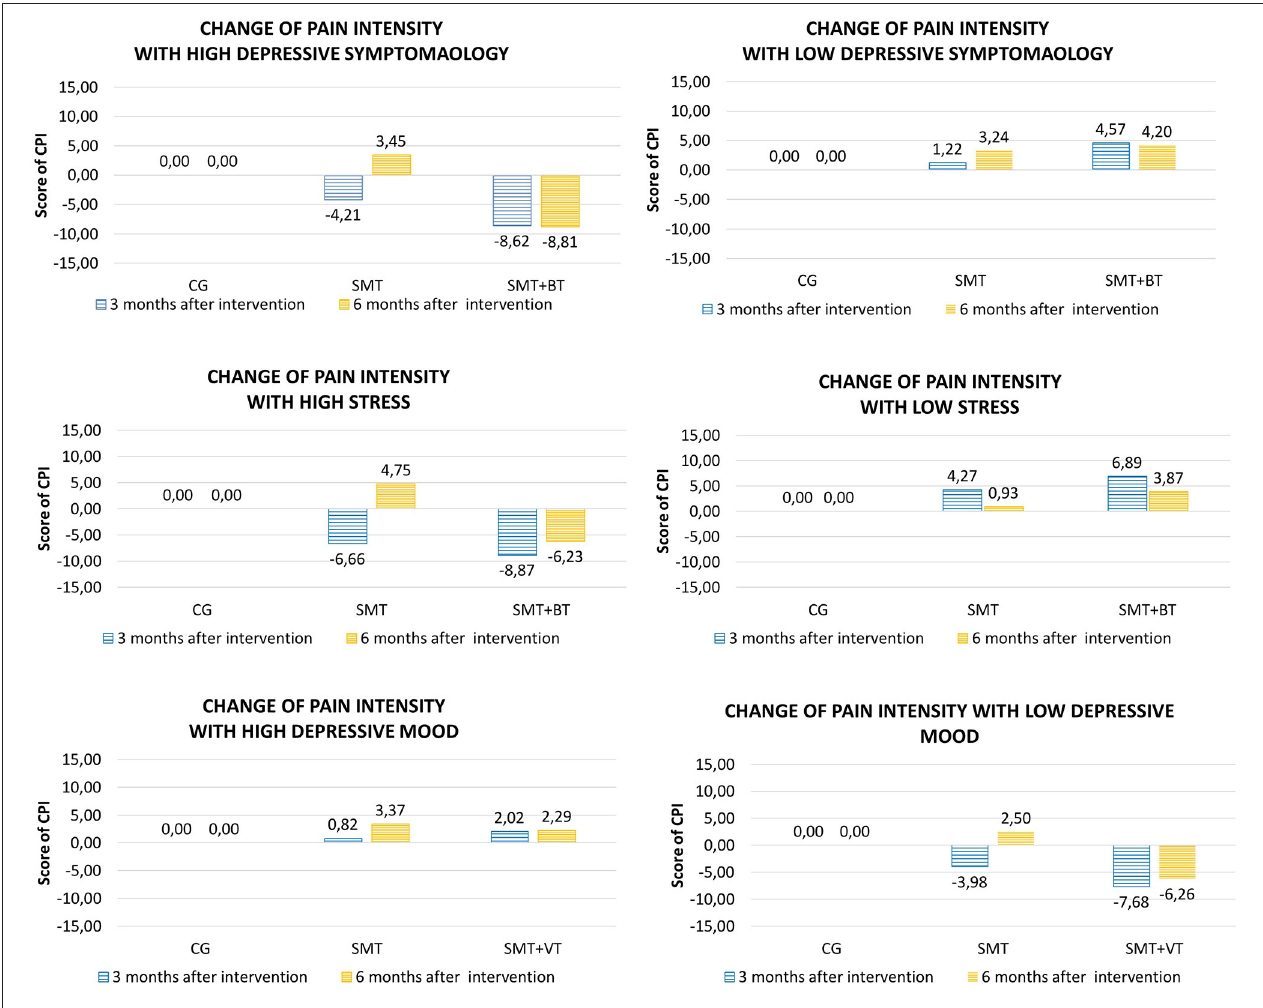
FIGURE 5 | Graphical presentation of the significant psychosocial moderators of Tables 2 , 3